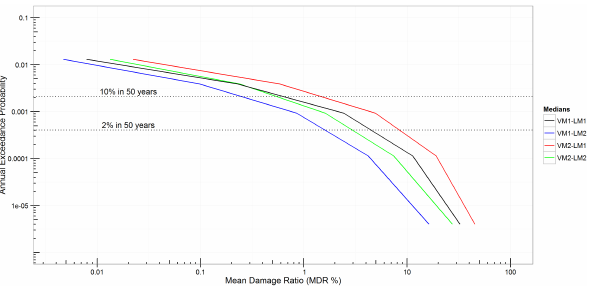
Figure 12. Comparison of the median estimates of seismic risk for the four different combinations of the vulnerability (VM) and loss (LM) models.